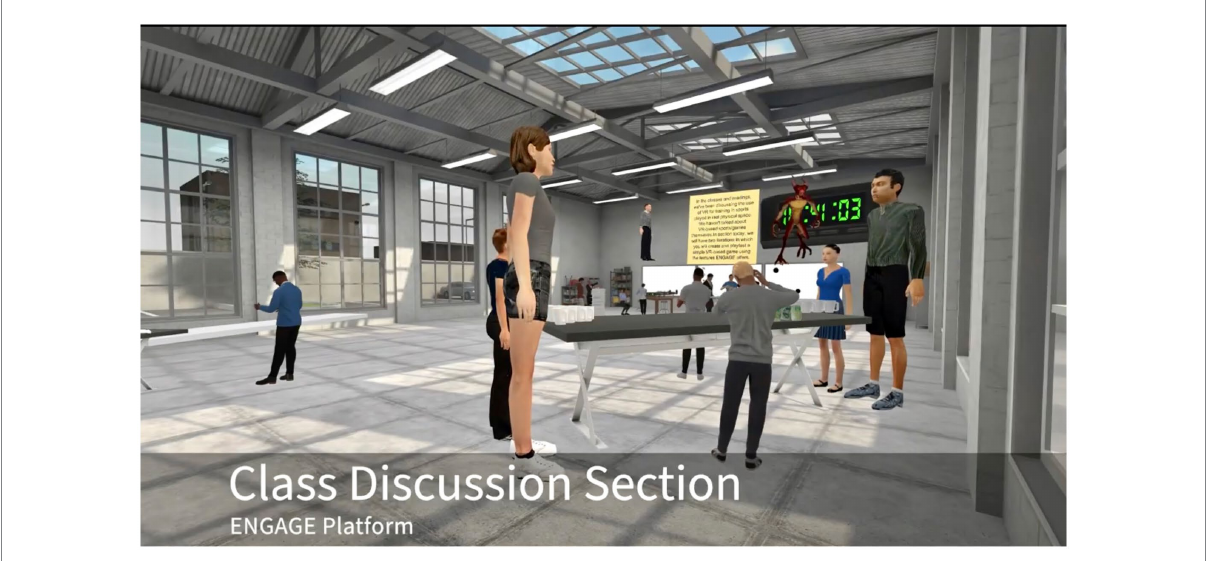
FIGURE 2 The class discussion section of “Virtual People” in the metaverse (Stanford University, 2021). Reproduced with